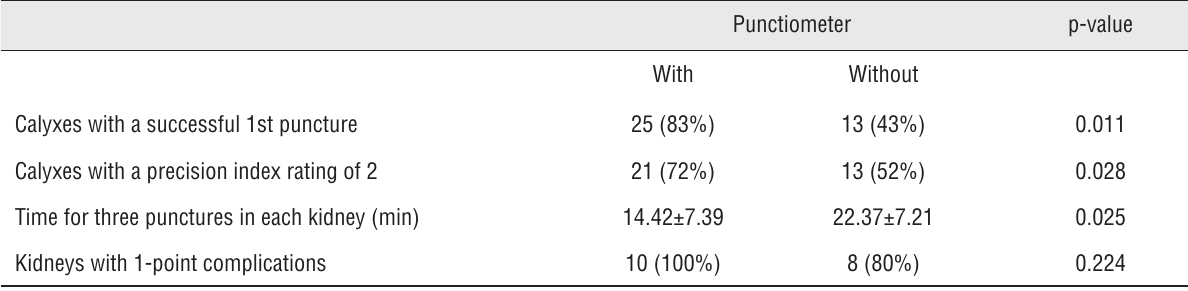
Punctiometer p-value With Without